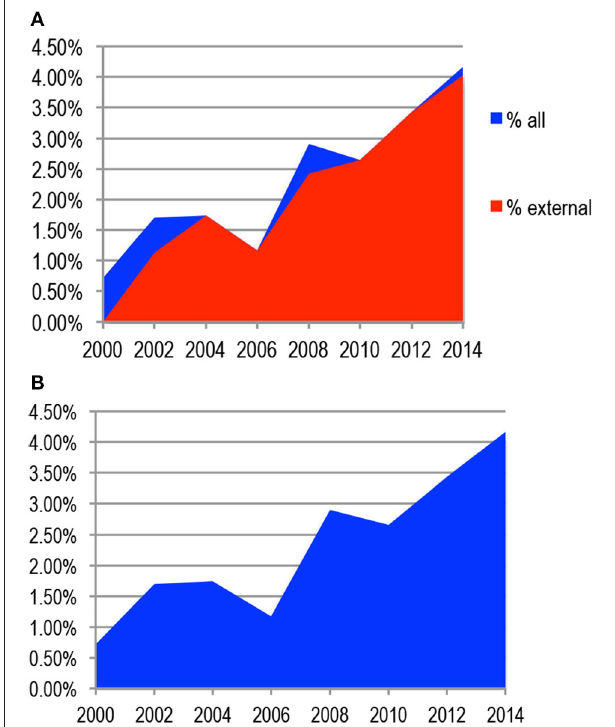
FIGURE 11 | (A) Presence of the term “cross validation” over the years. (B) Innovation Score of the term “cross validation”.